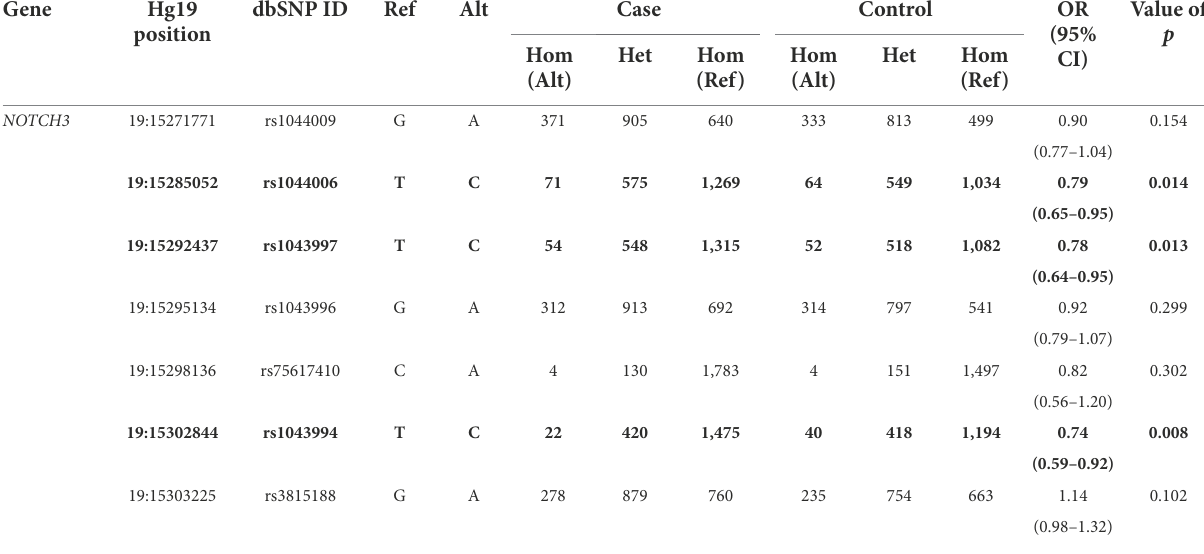
TABLE 1 Association analysis of common variants in the coding